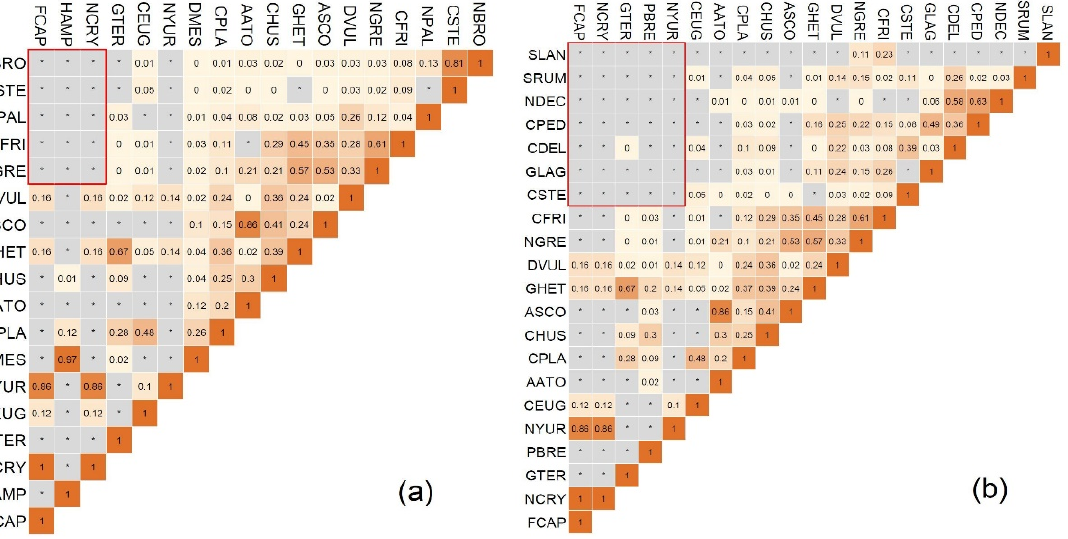
Figure 4. Matrix of coexistence index of each pair of diatom species which were selected by the coexistence-based approach, and the diatoms were ordered according to TI values based on ( a ) COD and ( b ) TP. Grey color means that two diatoms were not found at the same sampling location. The abbreviations of species are listed in Table 2.